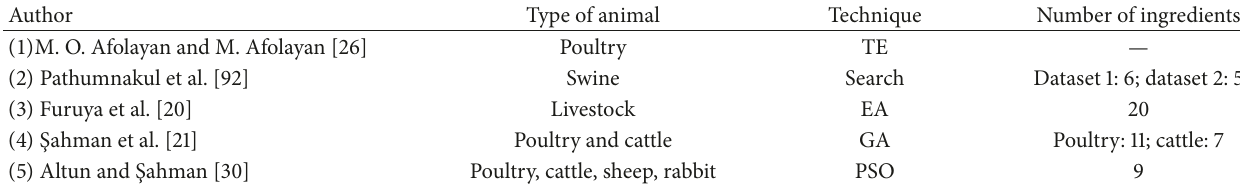
Table 1: Number of ingredients used in heuristic